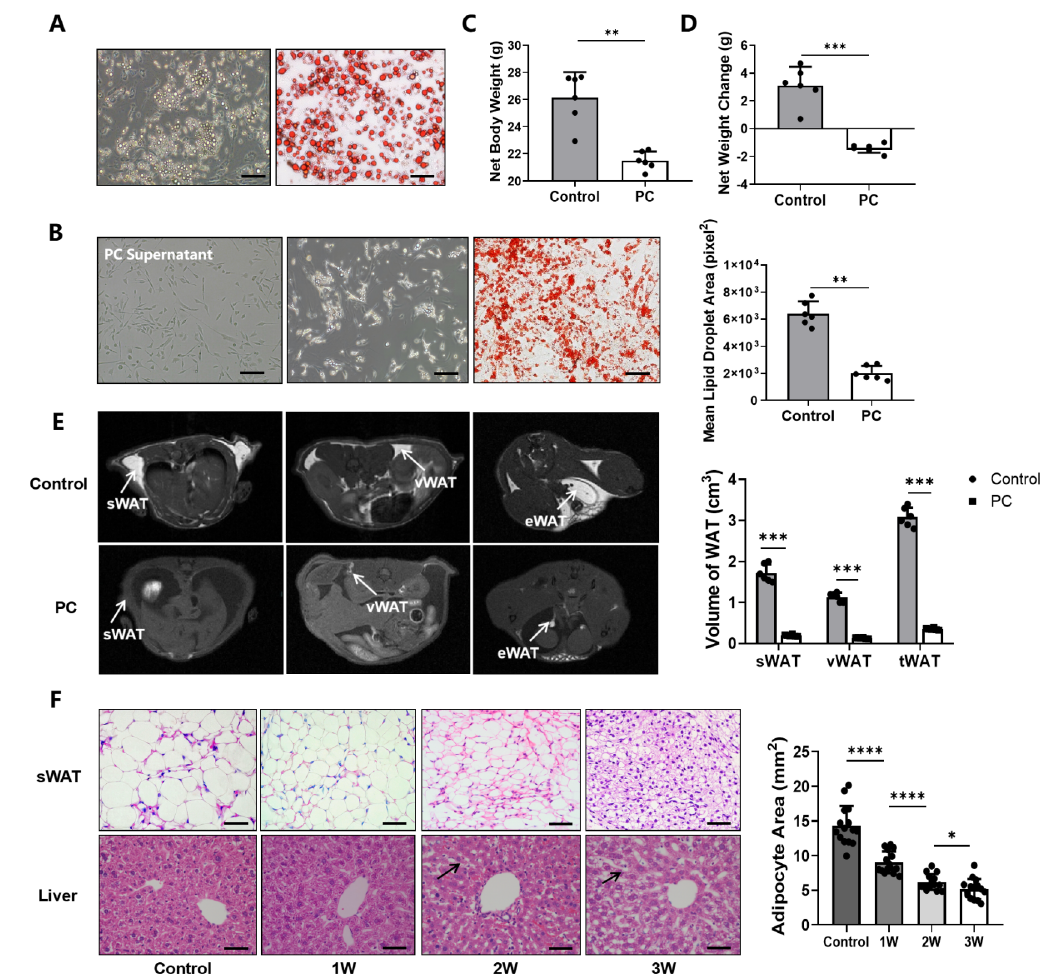
Figure 1. Pancreatic cancer induces abnormal fat metabolism and cachexia in the cell culture and animal model. ( A ) The mature primary white adipocytes after induction and identified by Oil Red O staining. ( B ) Panc02 cells in the left photo, primary white adipocytes in the middle photo and Oil Red O-stained primary white adipocytes in the right photo, followed by quantitative analysis of lipid droplets. ( C ) The weight of the control group and the net weight of the PC group after tumors and ascites were removed. ( D ) Changes in net body weight compared to baseline body weight. ( E ) T 1 WI MR images of healthy control mice and mice with pancreatic cancer and MRI-measured volumes of sWAT, vWAT and tWAT. ( F ) H&E staining of sWAT and liver in healthy control mice and pancreatic cancer mice as the disease progresses. (* p < 0.05, ** p < 0.01, *** p < 0.001, **** p < 0.0001). H&E = hematoxylin-eosin, iWAT = inguinal white adipose tissue, MRI = magnetic resonance imaging, PC = pancreatic cancer, sWAT = subcutaneous white adipose tissue, T 1 WI = T1 weighted image, tWAT = total white adipose tissue, vWAT = visceral white adipose tissue, WAT = white adipose tissue. H&E staining revealed that the size of the white adipocytes of sWAT and the size of lipid vesicles in tumor-bearing mice were smaller than those of the controls, and gradually decreased from week 1 to 3 as pancreatic cancer advanced further. Furthermore,